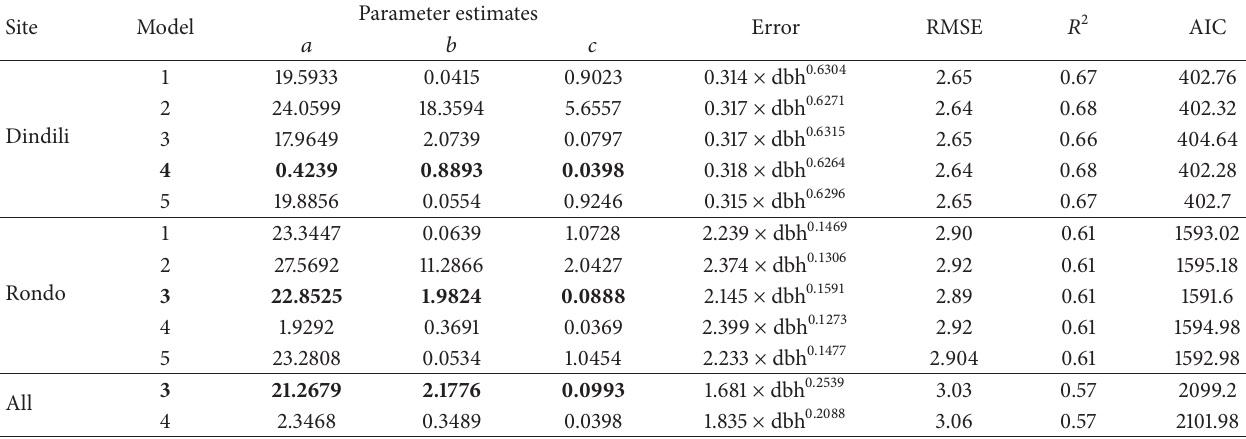
Table 2: Parameter estimates and performance criteria of five ht-dbh models.